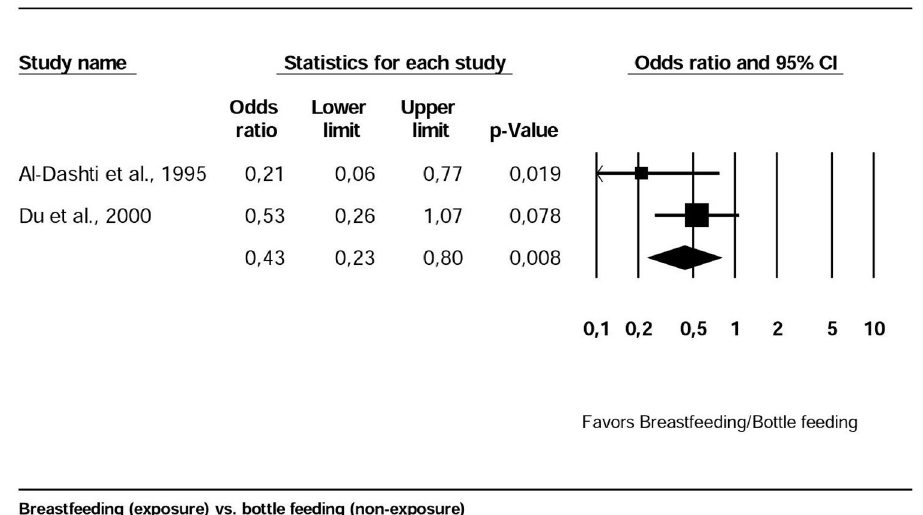
Fig 3. Forest plot of meta-analysis for four cross-sectional studies. Evaluates bottle or breast feeding practices and dental caries (outcome: presence of dental caries vs. absence of dental caries). Pooled effect measures [odds ratio (OR) and 95% confidence interval (CI)] indicated no statistically significant difference between breast and bottle fed children. I 2 = 33.14%. Fixed effect model used.